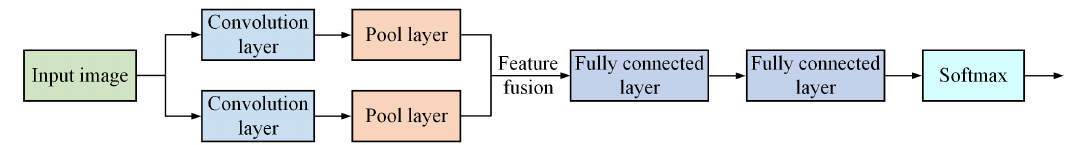
Figure 4. The work process of our proposed model.